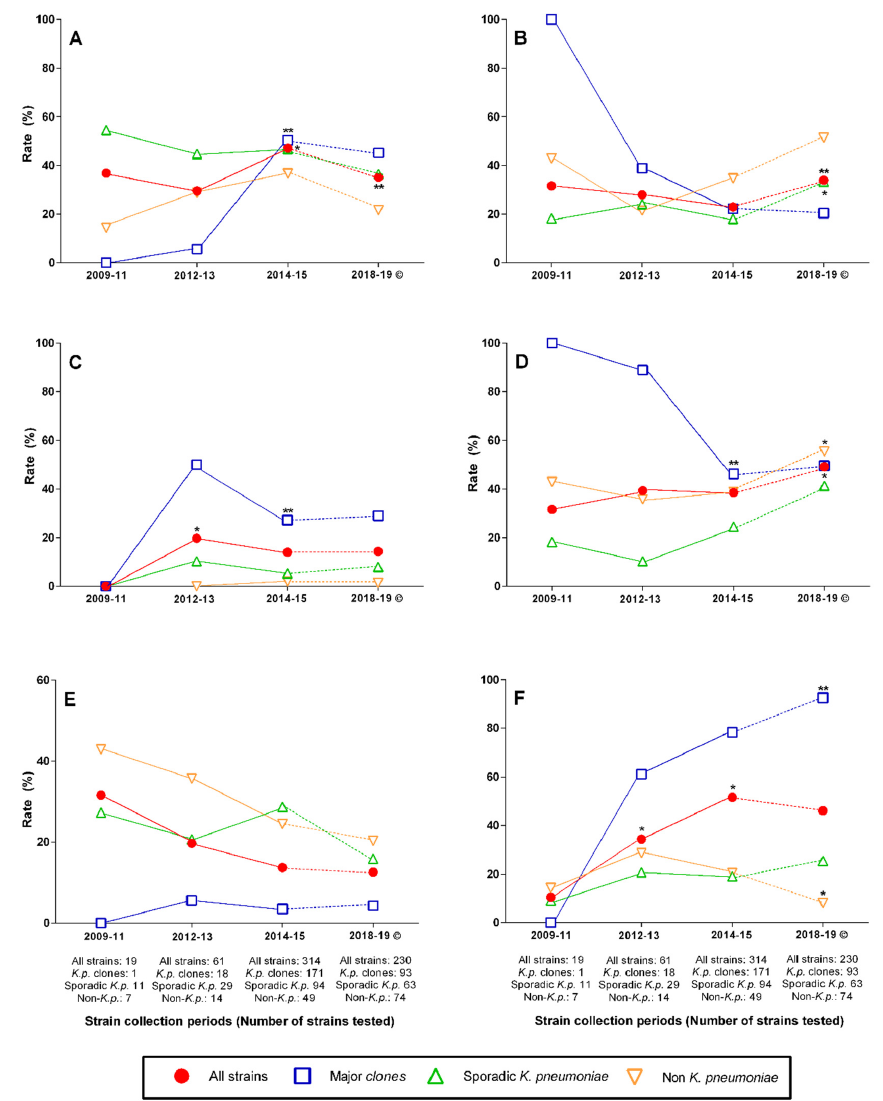
Figure 2. Changing rates of resistance-related genes over time: ( A ) bla OXA-48-like , ( B ) bla NDM , and ( C ) bla OXA-48-like and bla NDM . ( D ) Any metallo-beta-lactamase genes. ( E ) No carbapenemase genes. ( F ) Any 16S methylase genes. Continuous line: current study period; dashed line: changes until the most recent data © [20]. * Significantly ( p < 0.05); ** Highly significantly ( p < 0.01) different from previous point of time.